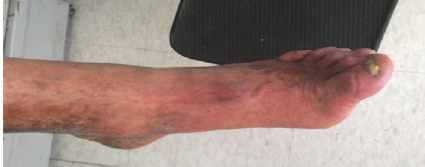
Figure 3: Left foot showing contractures, nail dystrophy, dermal atrophy, circumscribed hyperkeratosis and hyperpigmentation, and decreased subcutaneous fat and